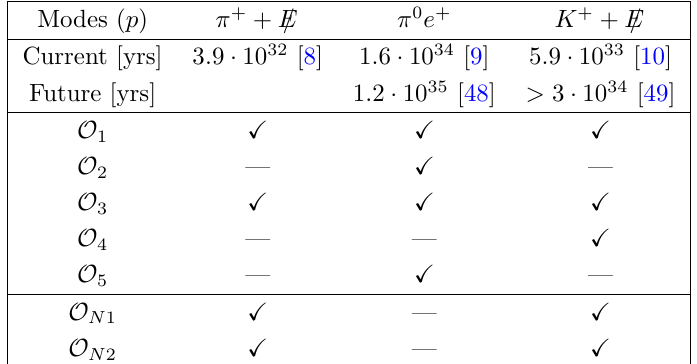
| X Table 1 . Operators and proton decay modes. The numbers in the \Current" and the \Future" rows are the current bounds and the future sensitivities at 90 % C.L. Only the operators O N 1 and O N 2 generate (cid:25) + + E= (missing energy), without producing the decay (cid:25) 0 e + .